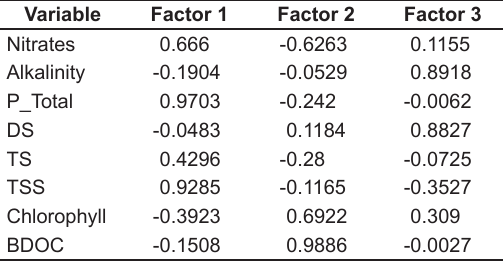
Table 6. Factor loadings for the physicochemical variables: the equations estimate the latent factors after rotation has been performed. Variables: Nitrates, Alkalinity, Total Phosphorous (P_Total), Dissolved Solids (DS), Total Suspended Solids (TSS), Total Solids (TS), Biodegradable Dissolved Organic Carbon (BDOC) and